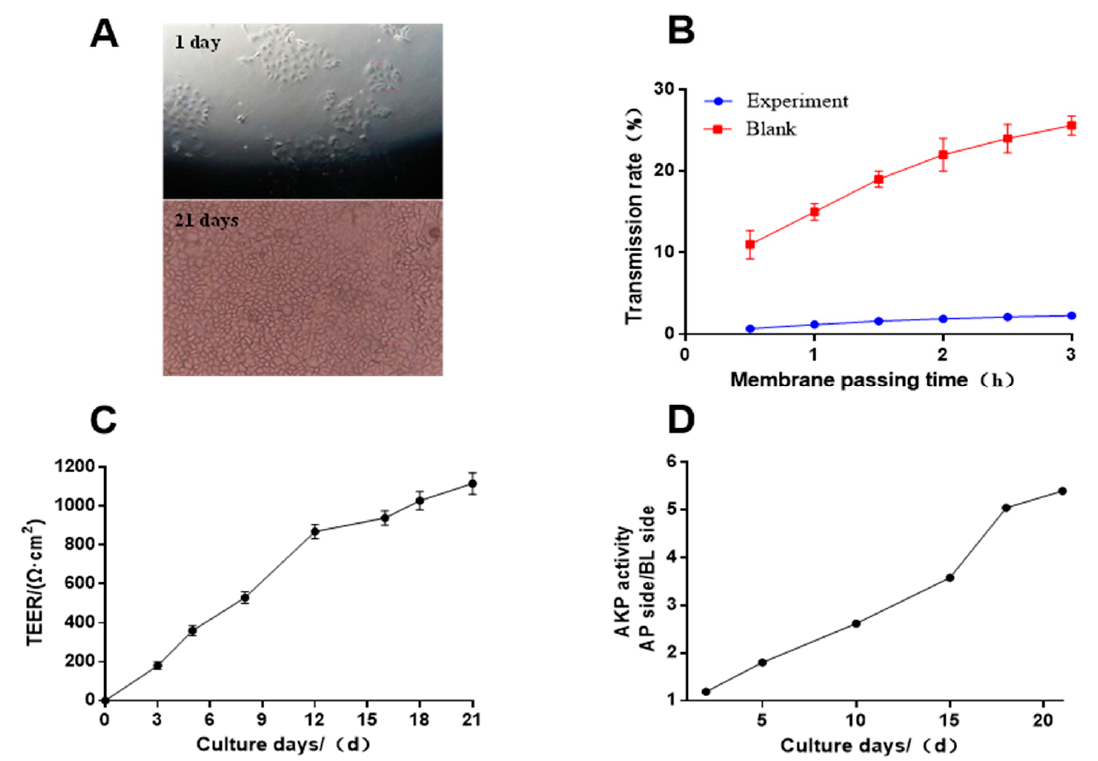
Figure 3. Evaluation of the monolayer density. ( A ) Caco-2 cells growth (10 × ). ( B ) Effect of trans- portation time on transmittance. ( C ) Effect of culture time on cell membrane resistance. ( D ) Effect of culture time on Alkaline phosphatase (AKP) activity